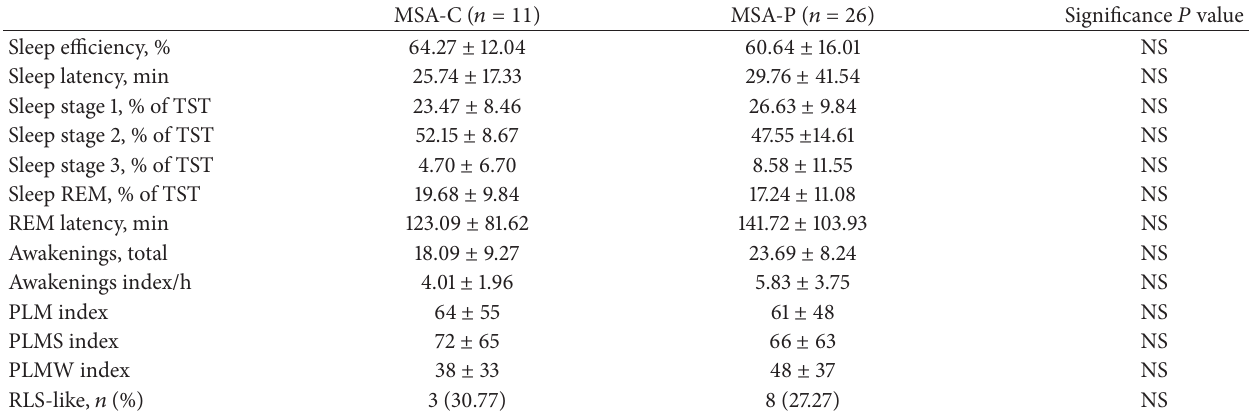
Table 2: Polysomnographic characteristics of MSA-C and MSA-P patients.